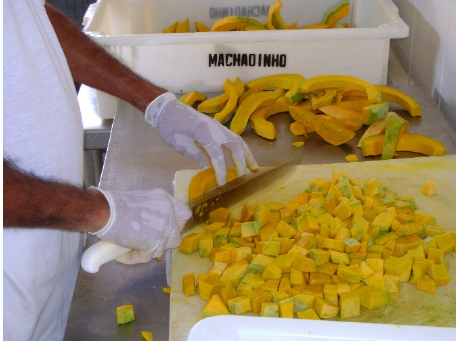
Figure 10. Small ‐ scale processing and packaging of vegetables for local supermarkets. Figure 10. Small-scale processing and packaging of vegetables for local